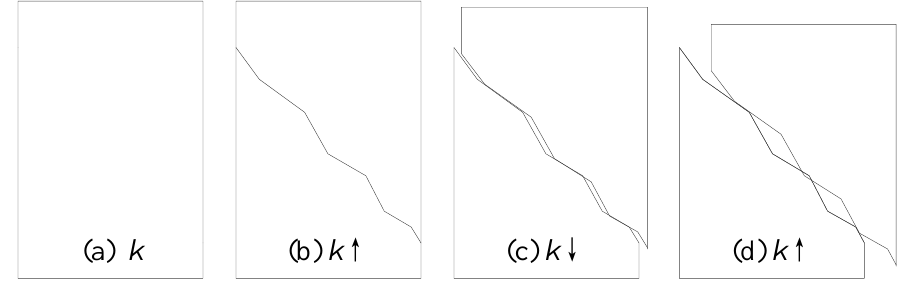
Figure 10. Fracture morphology and variation of permeability coefficient of rock under low confining pressure. ( a ) Intact rock sample; ( b ) Cracks appear in the rock sample and the k value increase; ( c ) The rock blocks on both sides of the rupture face slide and agree with each other, and the k value decreases; ( d ) The crack width increases under low confining pressure, and the k value increases.